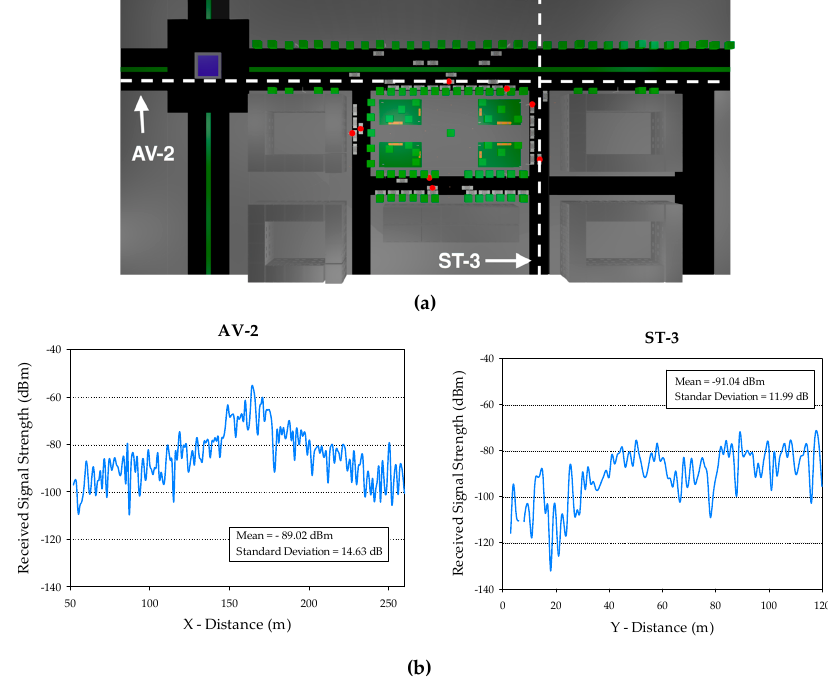
Figure 6. ( a ) Location of AV-2 and ST-3; ( b ) estimation of movement related standard deviation loss component for both locations. Table 4. Movement Related Standard Deviation Estimations.